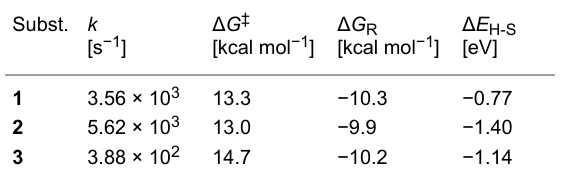
Table 3: Calculated kinetic and thermodynamic data (on the PW6B95- D3/QZVP//TPSS-D3/def2-TZVP level) and HOMO-SOMO gap Δ E H-S (on the TPSS-D3/TZVP level) of the reactions of 1 – 3 in benzene at 40